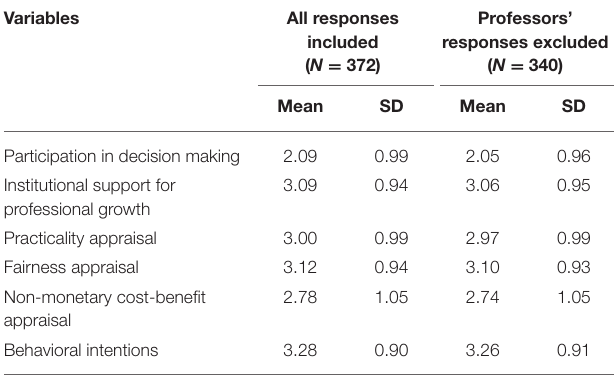
TABLE 3 | Demographic information of the 372 Chinese university teachers. TABLE 4 | The teachers’ profile of participation in decision-making, institutional support for professional growth, appraisal, and behavioral intentions.